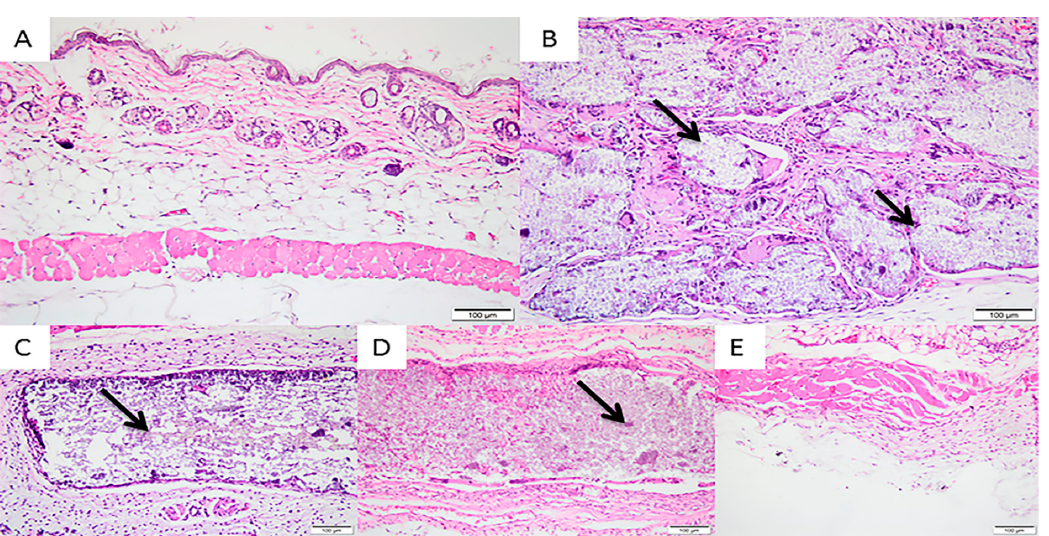
Figure 6. Photomicrographs of the experimental groups after 30 days of membrane implantation in the connective tissue. ( A ) Group 1 (Sham): discrete presence of lymphocytes and plasm cells and a moderate presence of macrophages; ( B ) Group 2 (200 µm): moderate presence of multinucleated giant cells and macrophages and a discrete presence of lymphocytes; (C) Group 3 (500 µm): discrete presence of lymphocytes, plasma cells, macrophages and a few multinucleated giant cells; ( D ) Group 4 (700 µm): discrete presence of lymphocytes and plasm cells, moderate presence of multinucleated giant cells and few polymorphonuclear cells; ( E ) Group 5 (Pratix ® ): discrete lymphoplasmacytic infiltration and a moderate infiltration of macrophages. Observe the fragmented aspect of the 200-µm membrane and non-fragmented aspects in the 500-µm and 700-µm groups. Arrow corresponds to the implanted membrane; Asterisk corresponds to the Pratix ® membrane site. (Magnification: 200×, Stain: Hematoxylin and Eosin).